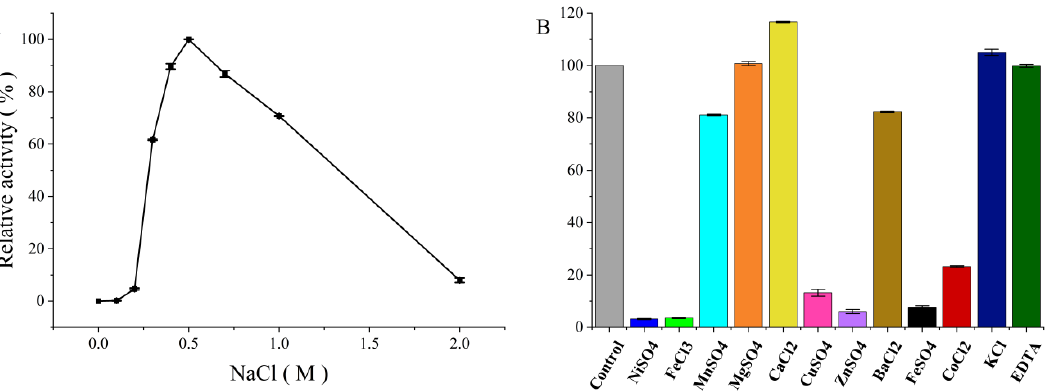
Figure 5. Effects of metal ions on the enzymatic activity of the novel alginate lyase (PMD). ( A ) Effect of NaCl on the enzymatic activity of PMD; ( B ) effects of metal ions on the activity of PMD.